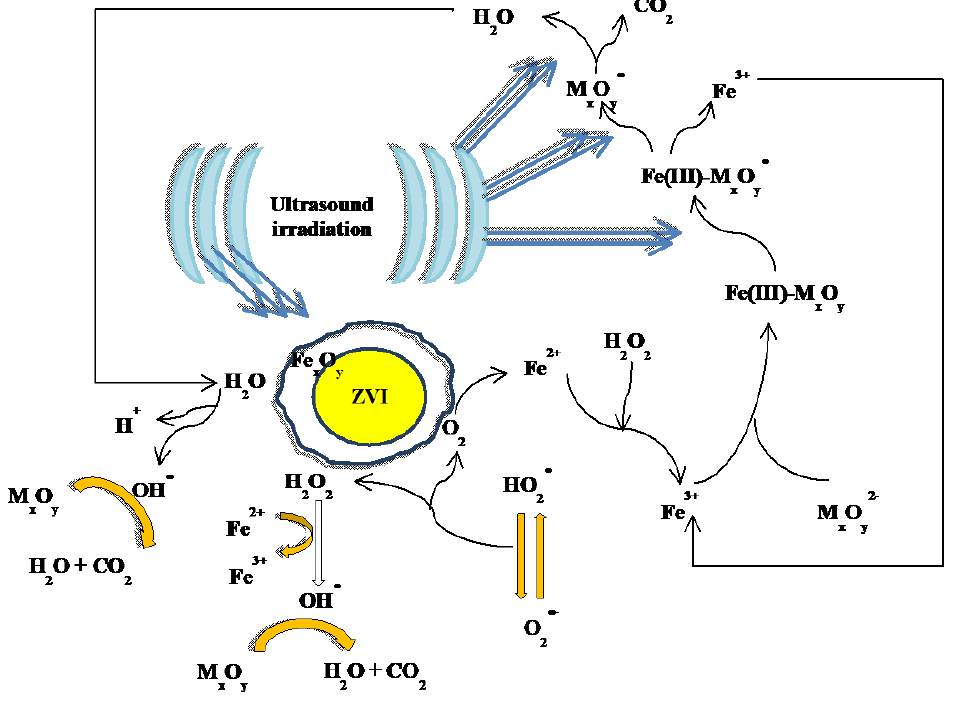
Figure 3. Schematic of a typical ultrasound-ZVI-Fenton mechanism (note that M x O y represents a generic organic pollutant).